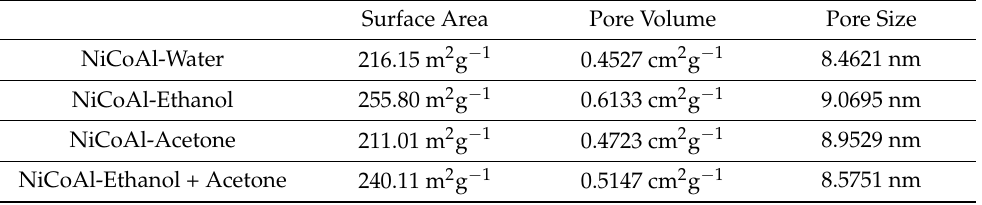
Table 4. Textural Properties for NiCoAl-Water, NiCoAl-Ethanol, NiCoAl-Acetone, and NiCoAl- Ethanol +